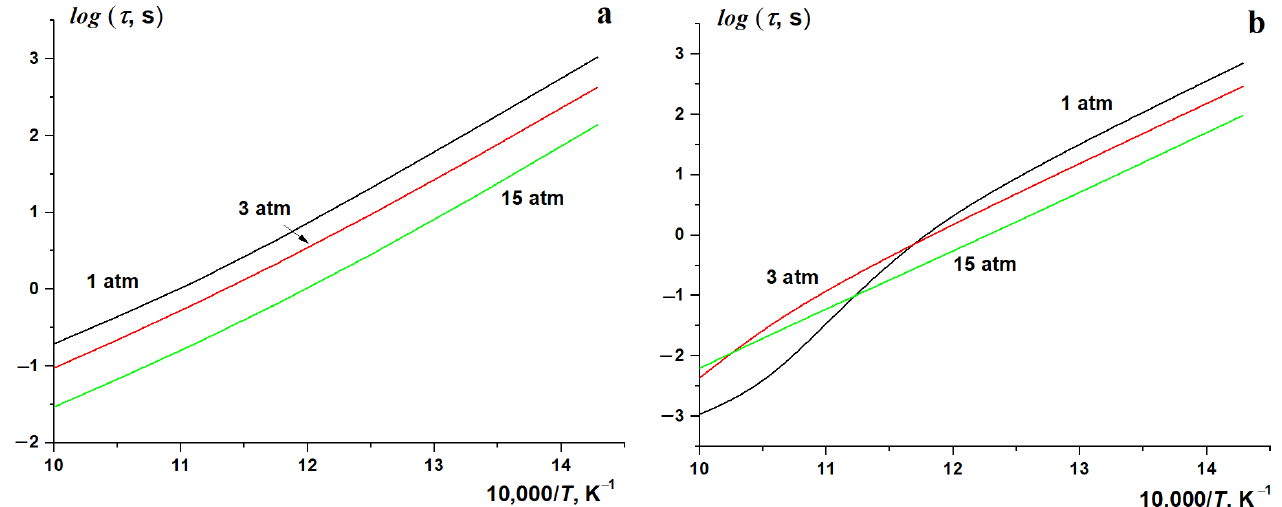
Figure 9. Temperature dependence of autoignition delay time for stoichiometric methane–hydrogen–air mixtures at various initial pressures and hydrogen concentrations; ( a ) [H 2 ] = 20%, ( b ) [H 2 ] = 80%.